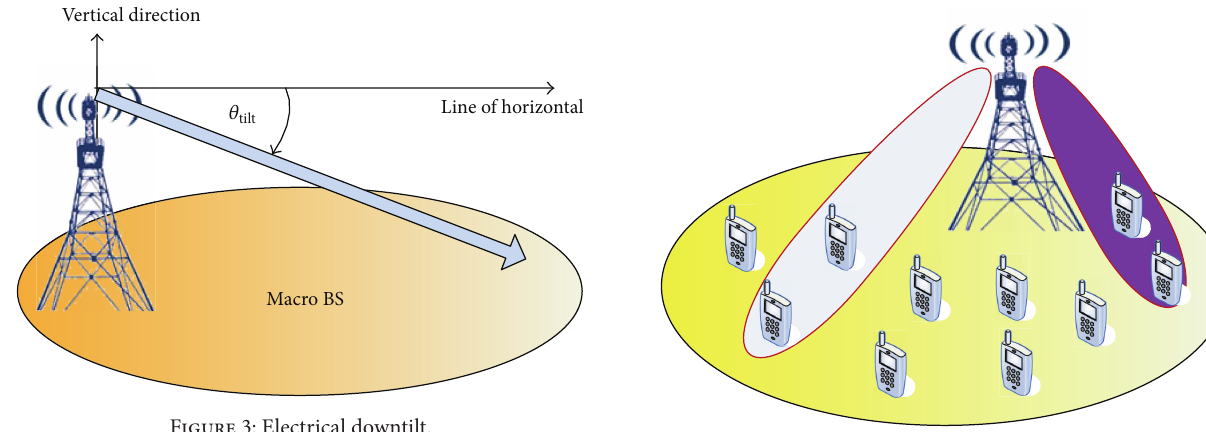
Figure 4: Conventional 2D MIMO